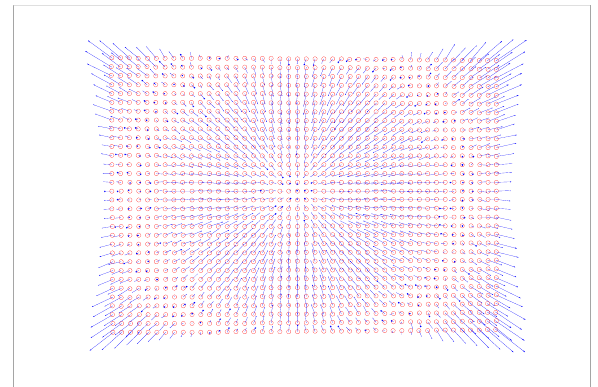
Figure 6. Illustration of the distortion values. The scale of the vectors is 1:50. The calibration field do not cover the whole format of the sensor due to difference in principal distance of the pinhole and glass OS (approx. 55/40)